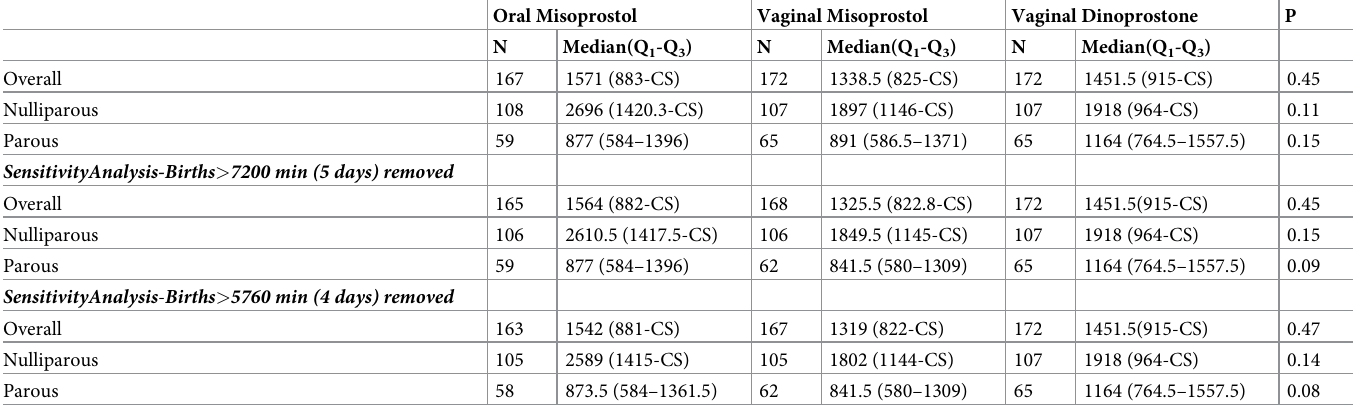
Table 5. Nonparametric analyses induction intervals to vaginal birth by parity (in